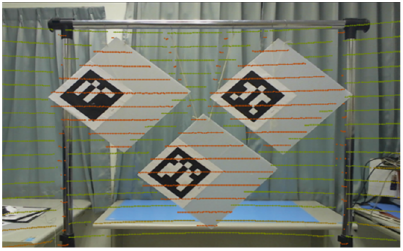
Figure 15. Projection result of using three calibration